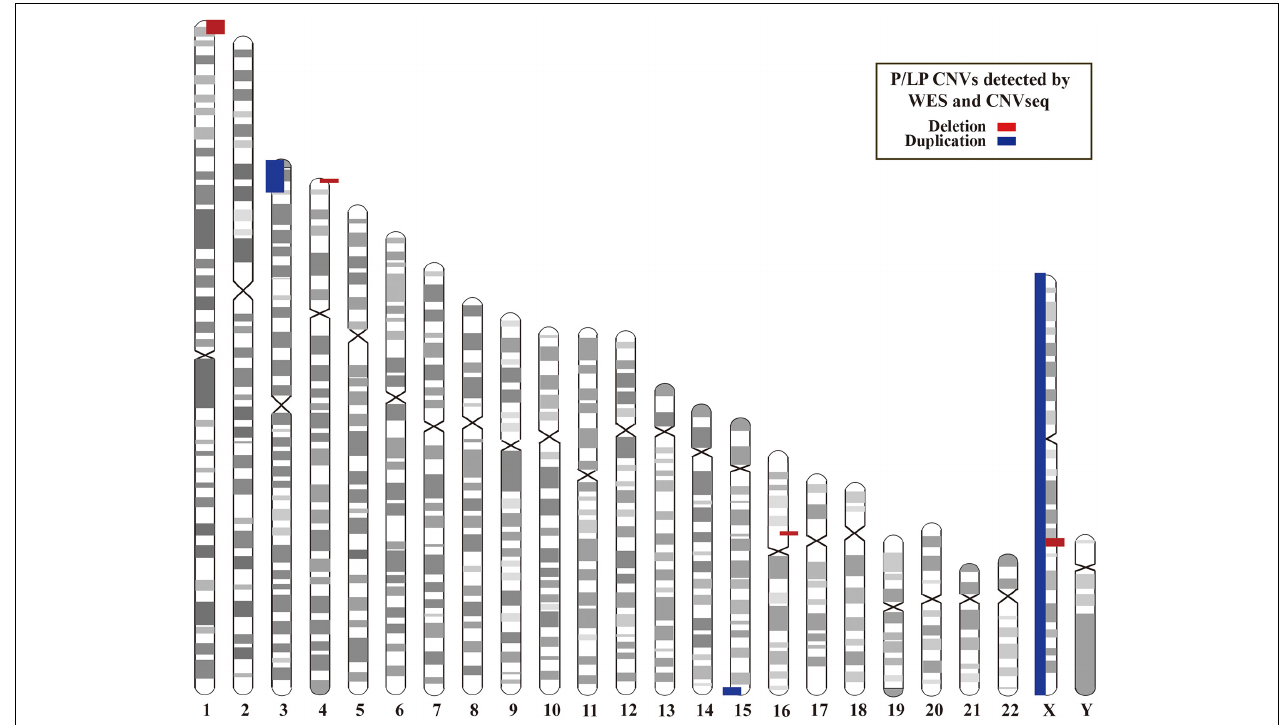
FIGURE 4 | Locations of P/LP CNVs identified by WES and/or CNVseq. CNV, copy number variant; CNVseq, CNV sequencing; WES, whole-exome sequencing.